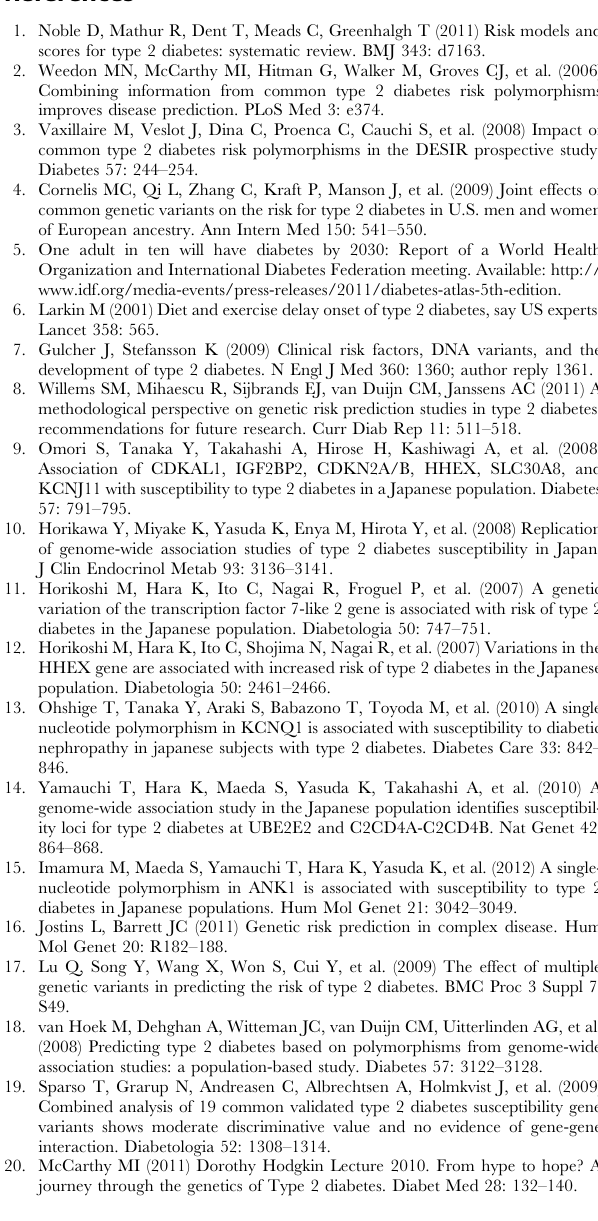
Table S1 Top-ranked 10 SNPs defined in ABF. Table S2 The top AUCs observed in elastic net method and the number of SNPs used in risk prediction model